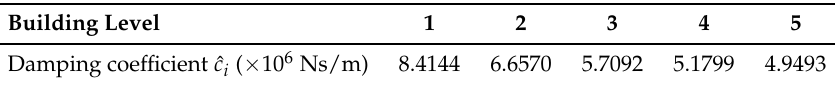
Table 3. Damping coefficients of the interstory FVD system.